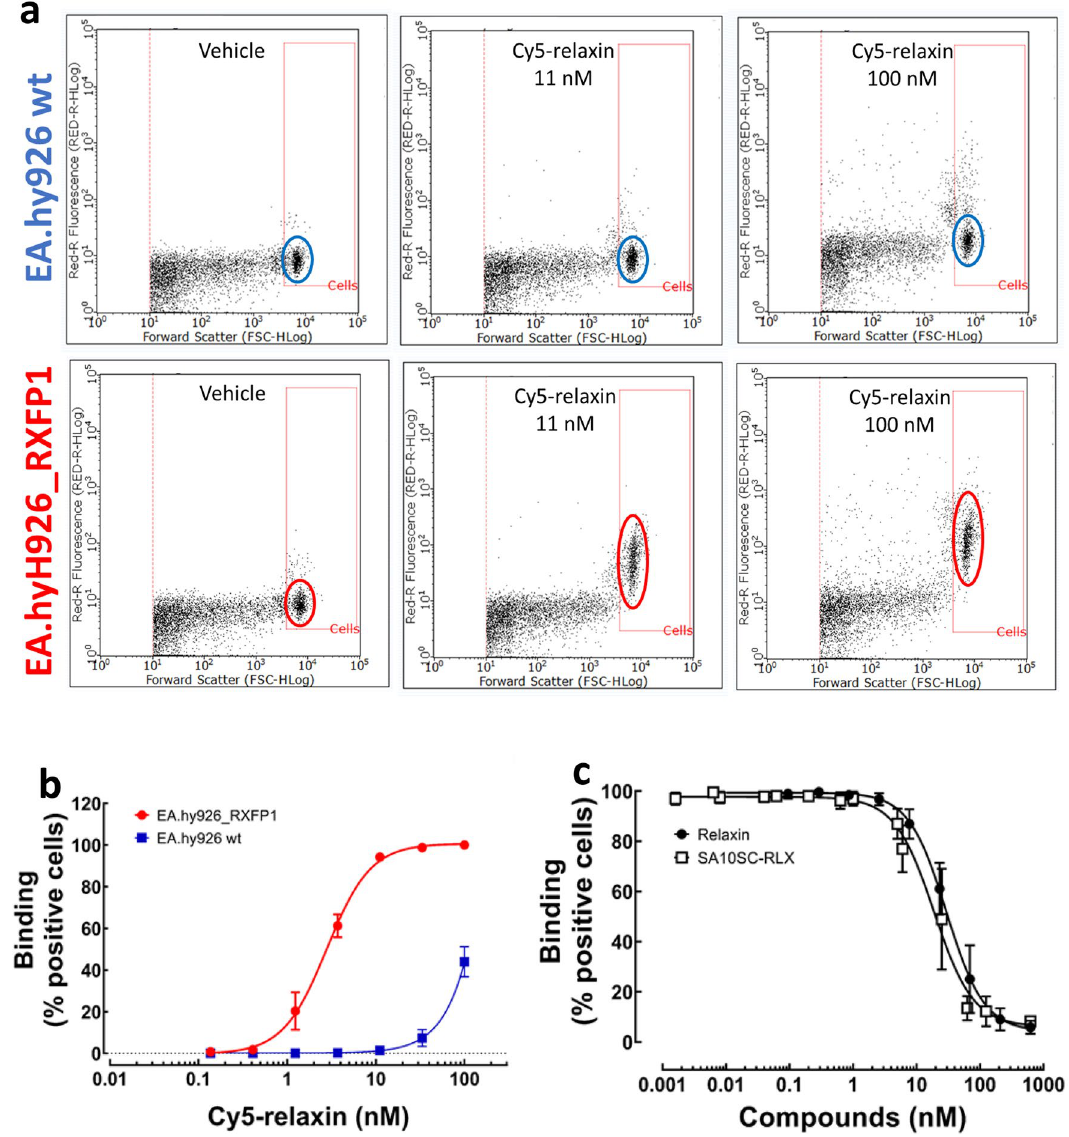
Figure 1. SA10SC-RLX binding to human RXFP1. Flow cytometry analysis ( a ) of two concentrations (11 and 100 nM) of Cy5-relaxin binding in wild type (wt) EA.hy926 cells (upper panel) or EA.hy926_RXFP1 cells (lower panel). The Y axis represents fluorescence intensity and the X axis the size of the particles. ( a ) is representative of 3 independent experiments with similar results. Concentration-dependent binding of Cy5-relaxin binding in wild type EA.hy926 cells (blue curve) or EA.hy926_RXFP1 cells (red curve) (mean ± SEM, n = 3 different experiments performed in duplicate) ( b ). Inhibition of 11 nM Cy5 relaxin binding by increasing concentration of unlabeled relaxin or SA10SC-RLX (mean ± SEM, n = 4 different experiments performed in duplicate) ( c